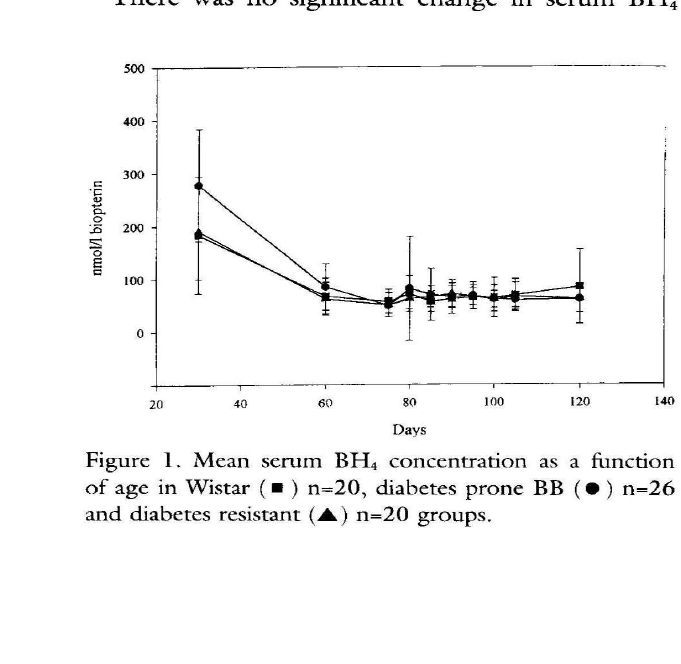
Figure 1. Mean serum BH. concentration as a function of age in Wistar ( . ) n=20, diabetes prone BB (. ) n=26 and diabetes resistant ( .... ) n=20 groups.